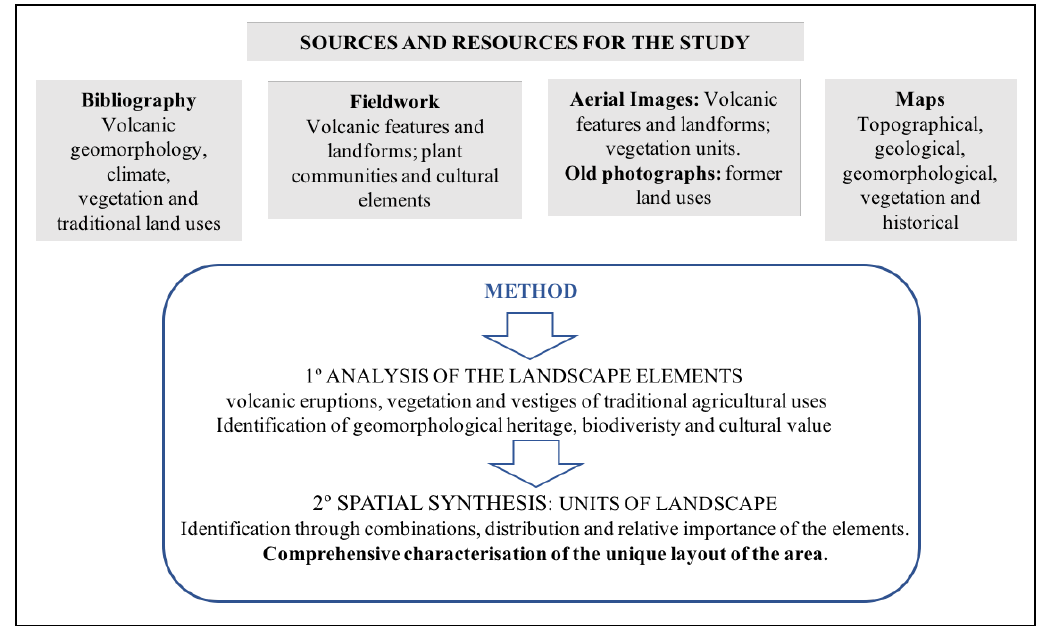
Figure 1. Sources, resources, and methodology of the natural landscape study. Source: self-elaboration. The proposed landscape trail will follow a route that runs around the perimeter of the eruptive centres of Chinyero and has been designed with different stops for exploration and interpretation of the landscape units and elements of their natural and cultural heritage (Figure 2).